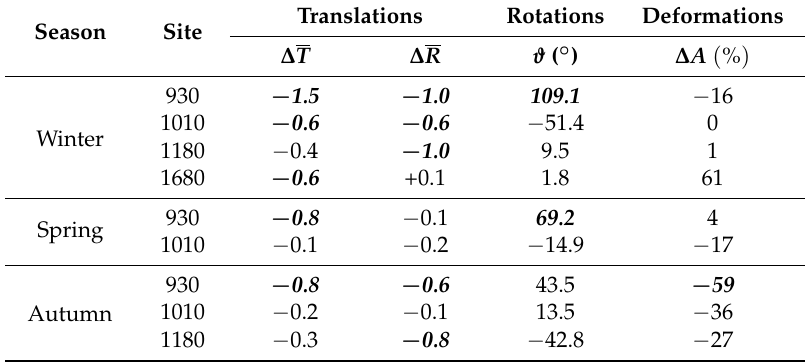
Table 4. Displacements of the 95% contour ellipses corresponding to each station and variable passing from 1951–1980 to 1981–2010. (Statistically significant results at 95% confidence level are in bold